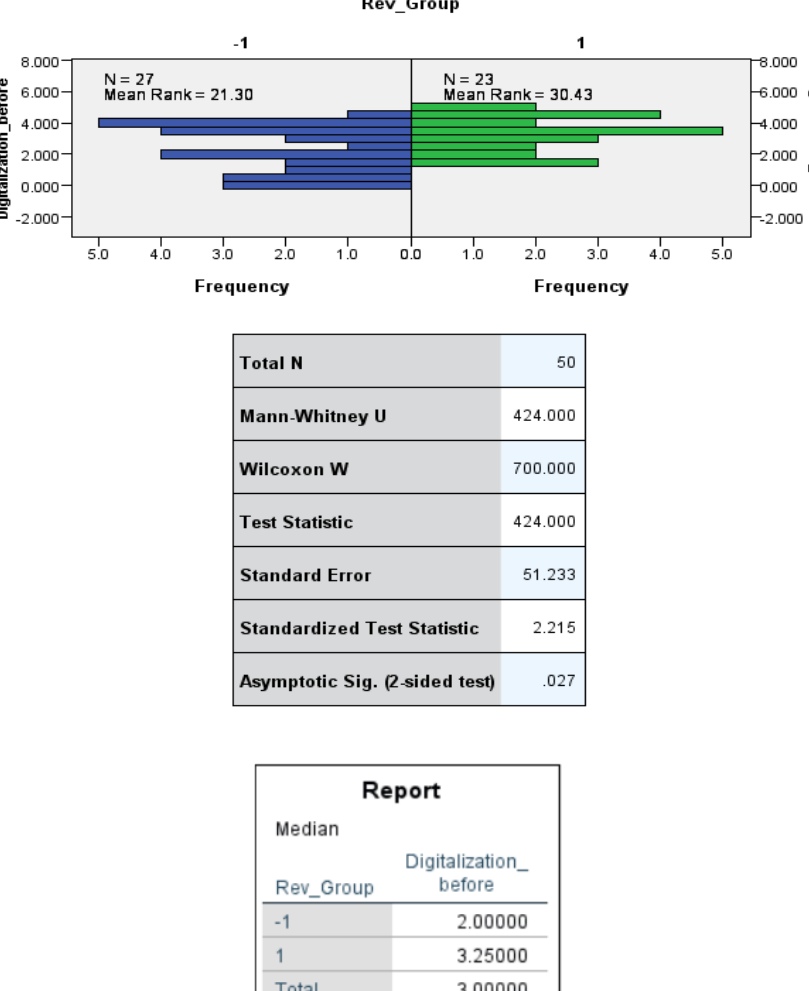
Figure 3. Results of the Independent-Samples Mann-Whitney U